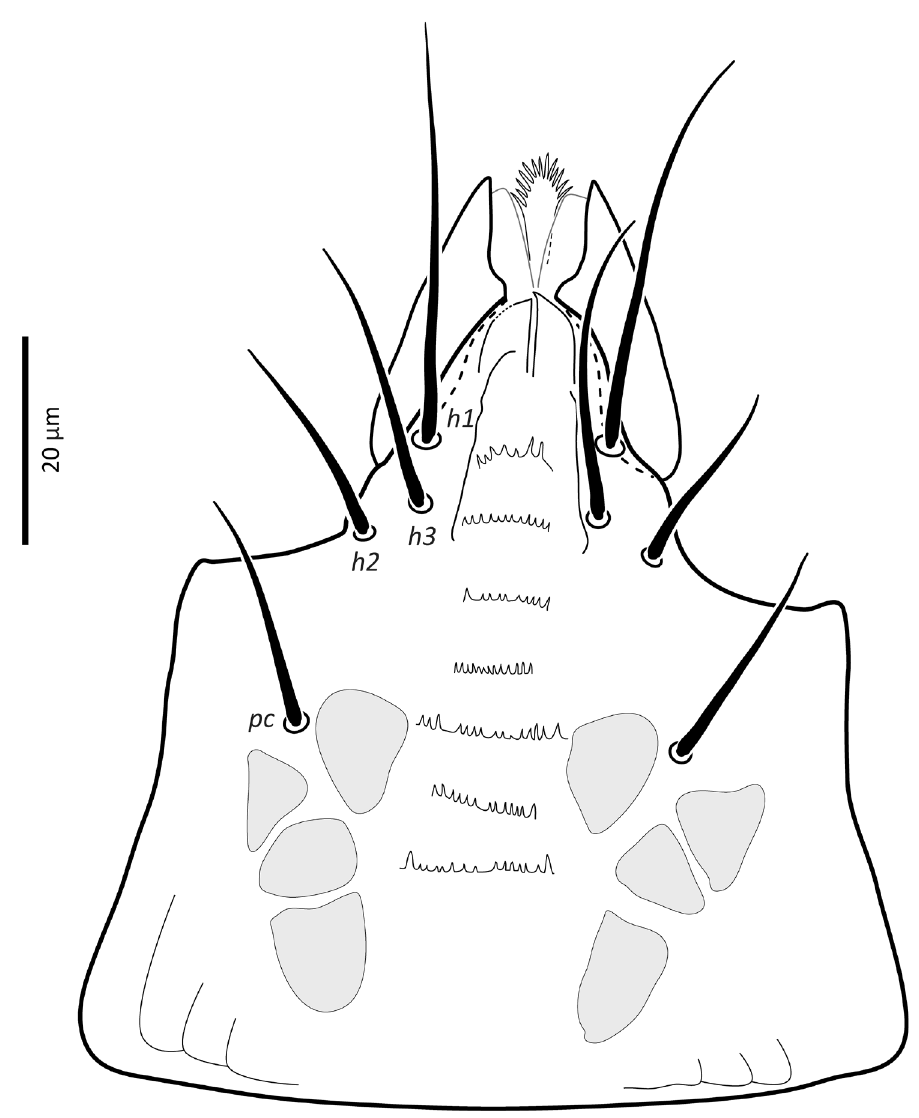
Figure 7. Zygoseius papaver sp. n., female, subcapitulum.